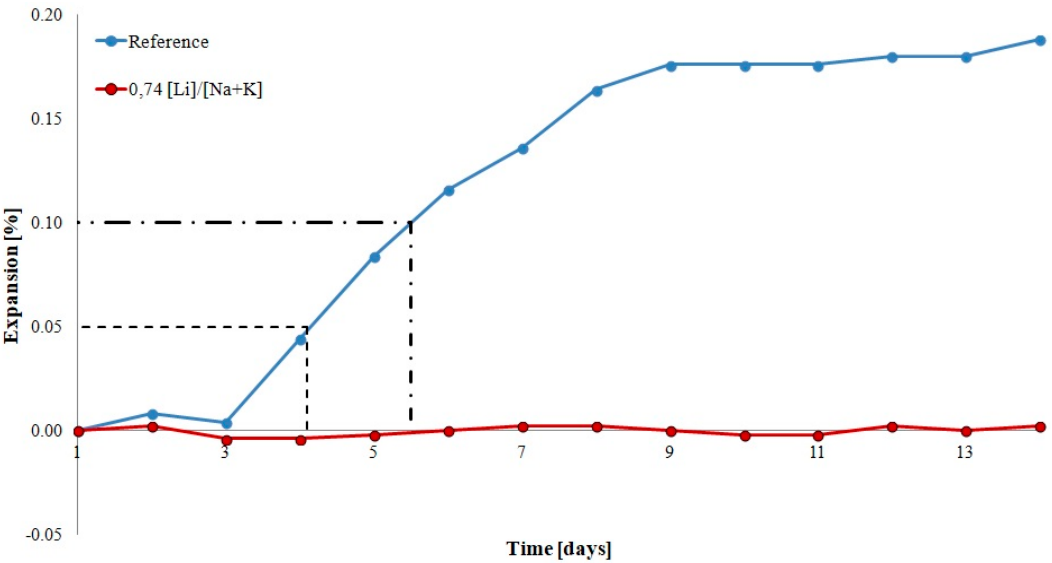
Figure 2. Expansion of mortars with reactive opal aggregate.